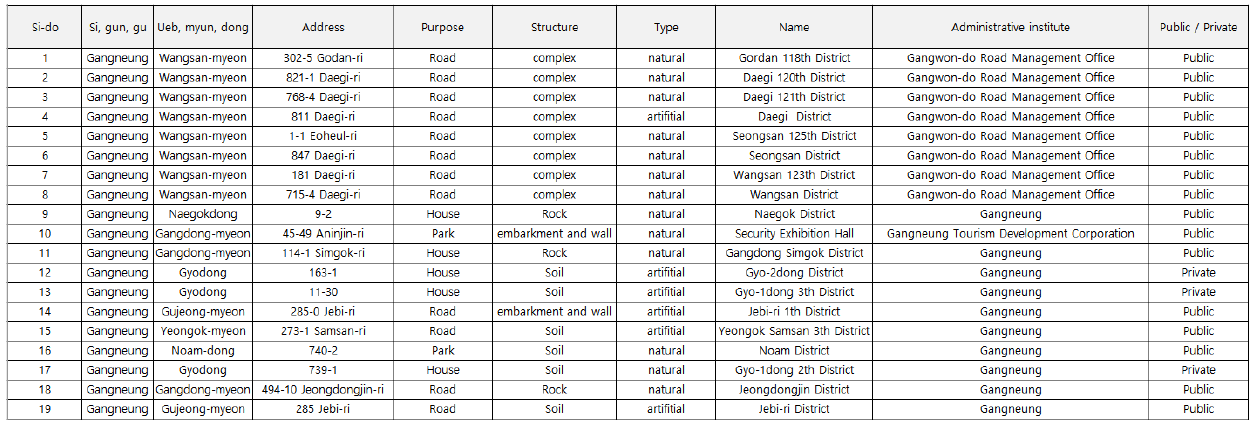
Figure 10. Complex GGSJ (artificial soil slope, artificial rock slope, gabion, concrete embarkment).